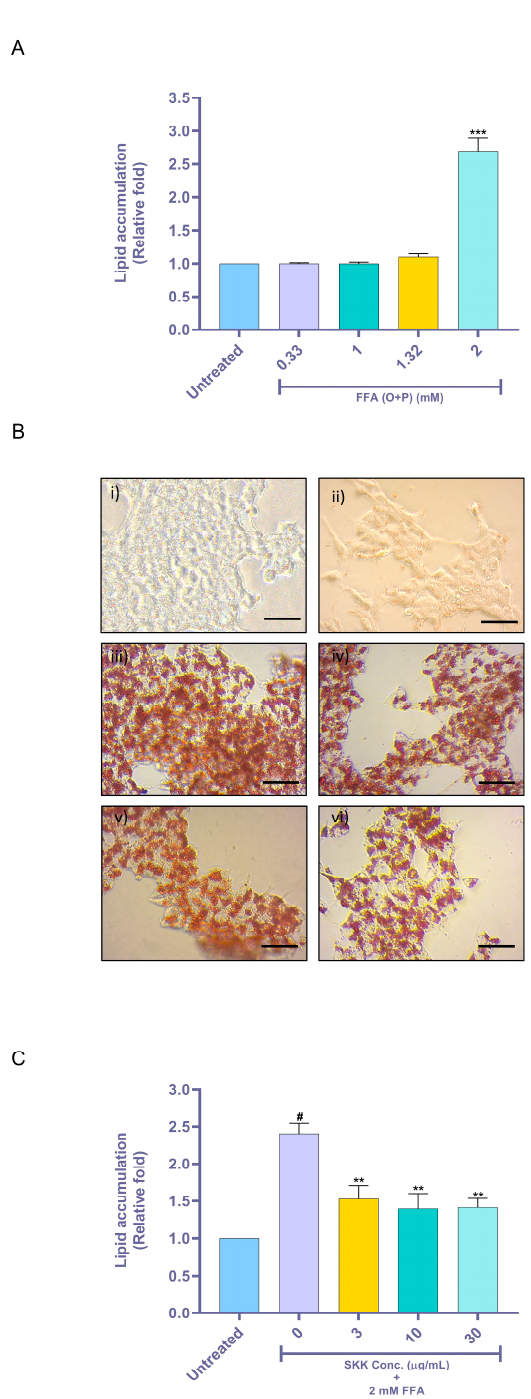
1 Figure 3. Intracellular lipid accumulation and its amelioration by SKK. ( A ) Intercellular lipid accumulation was evaluated in HepG2 cells following treatment with varying combinations of oleic acid (O) and palmitic acid (P). ( B ) Visual analysis for oil red ‘O” dye accumulation associated with neutral lipids was performed in the HepG2 cells following pretreatment with SKK (0, 3, 10, and 30 µ g / mL) for 24 h, and thereafter a combined treatment of SKK (0, 3, 10, and 30 µ g / mL), and 2 mM FFA for 48 h. The scale bar in the images represents 20 µ m. ( C ) ORO staining results showed that SKK pretreatment inhibited the intracellular lipid accumulation stimulated by FFA exposure in the HepG2 cells. All the experiments were performed thrice in triplicate and the results are displayed as mean ± SEM. For statistical analysis, one-way ANOVA with Dunnett’s multiple comparisons was done, where untreated vs. FFA = *** p value < 0.001, untreated control vs. 0 µ g / mL = # p value < 0.001, and SKK test concentrations vs. 0 µ g / mL = ** p value <